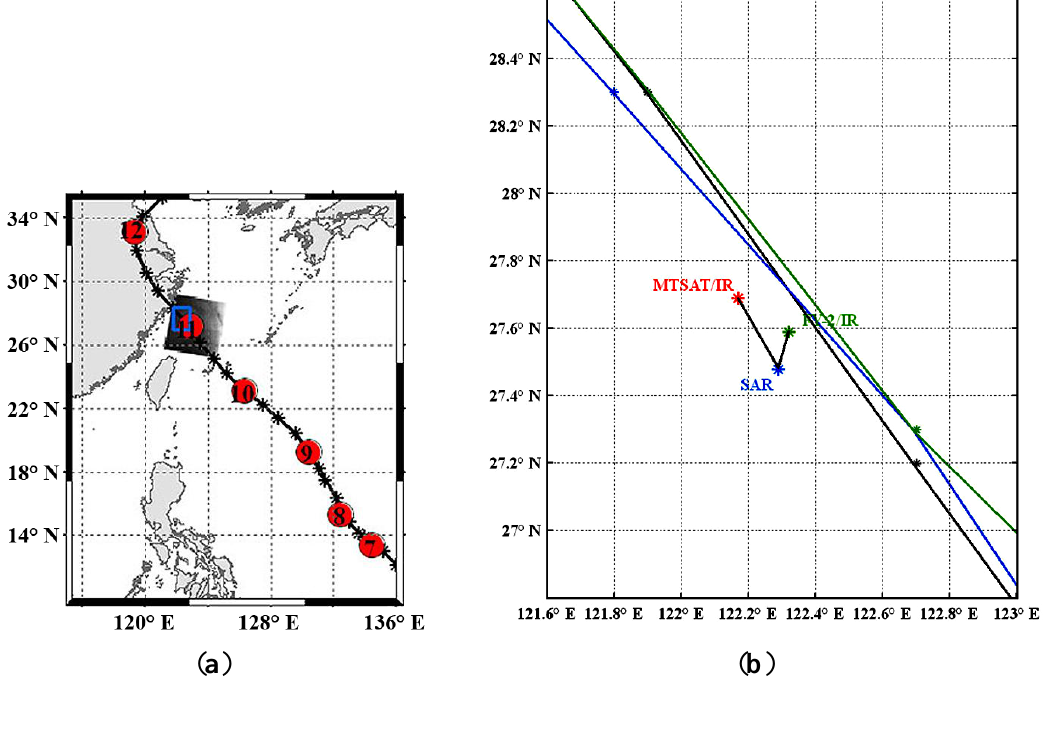
Figure 8. ( a ) Regional typhoon track map from 7 September to 12 September; and ( b ) extracted typhoon eyes’ center from SAR data and IR images when Typhoon Khanun was passing through north of Taiwan on 11 September